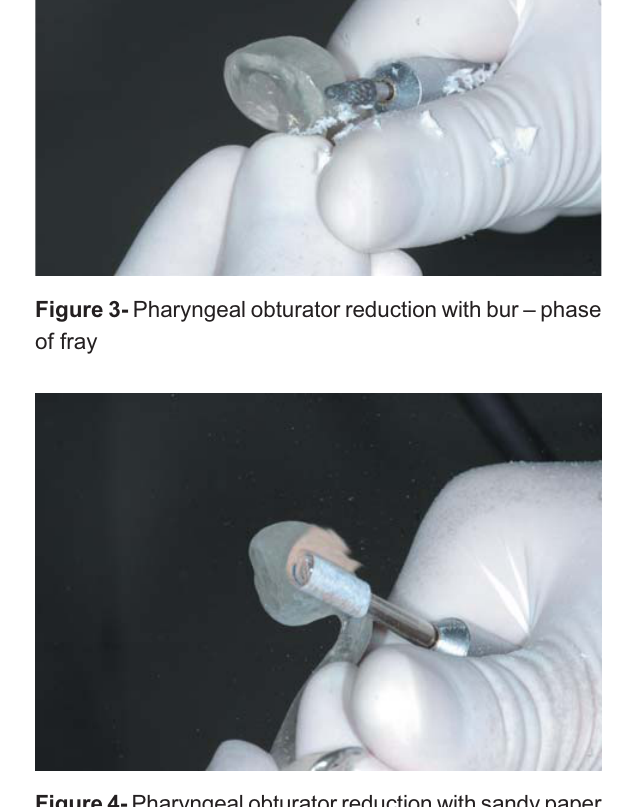
Figure 4- Pharyngeal obturator reduction with sandy paper